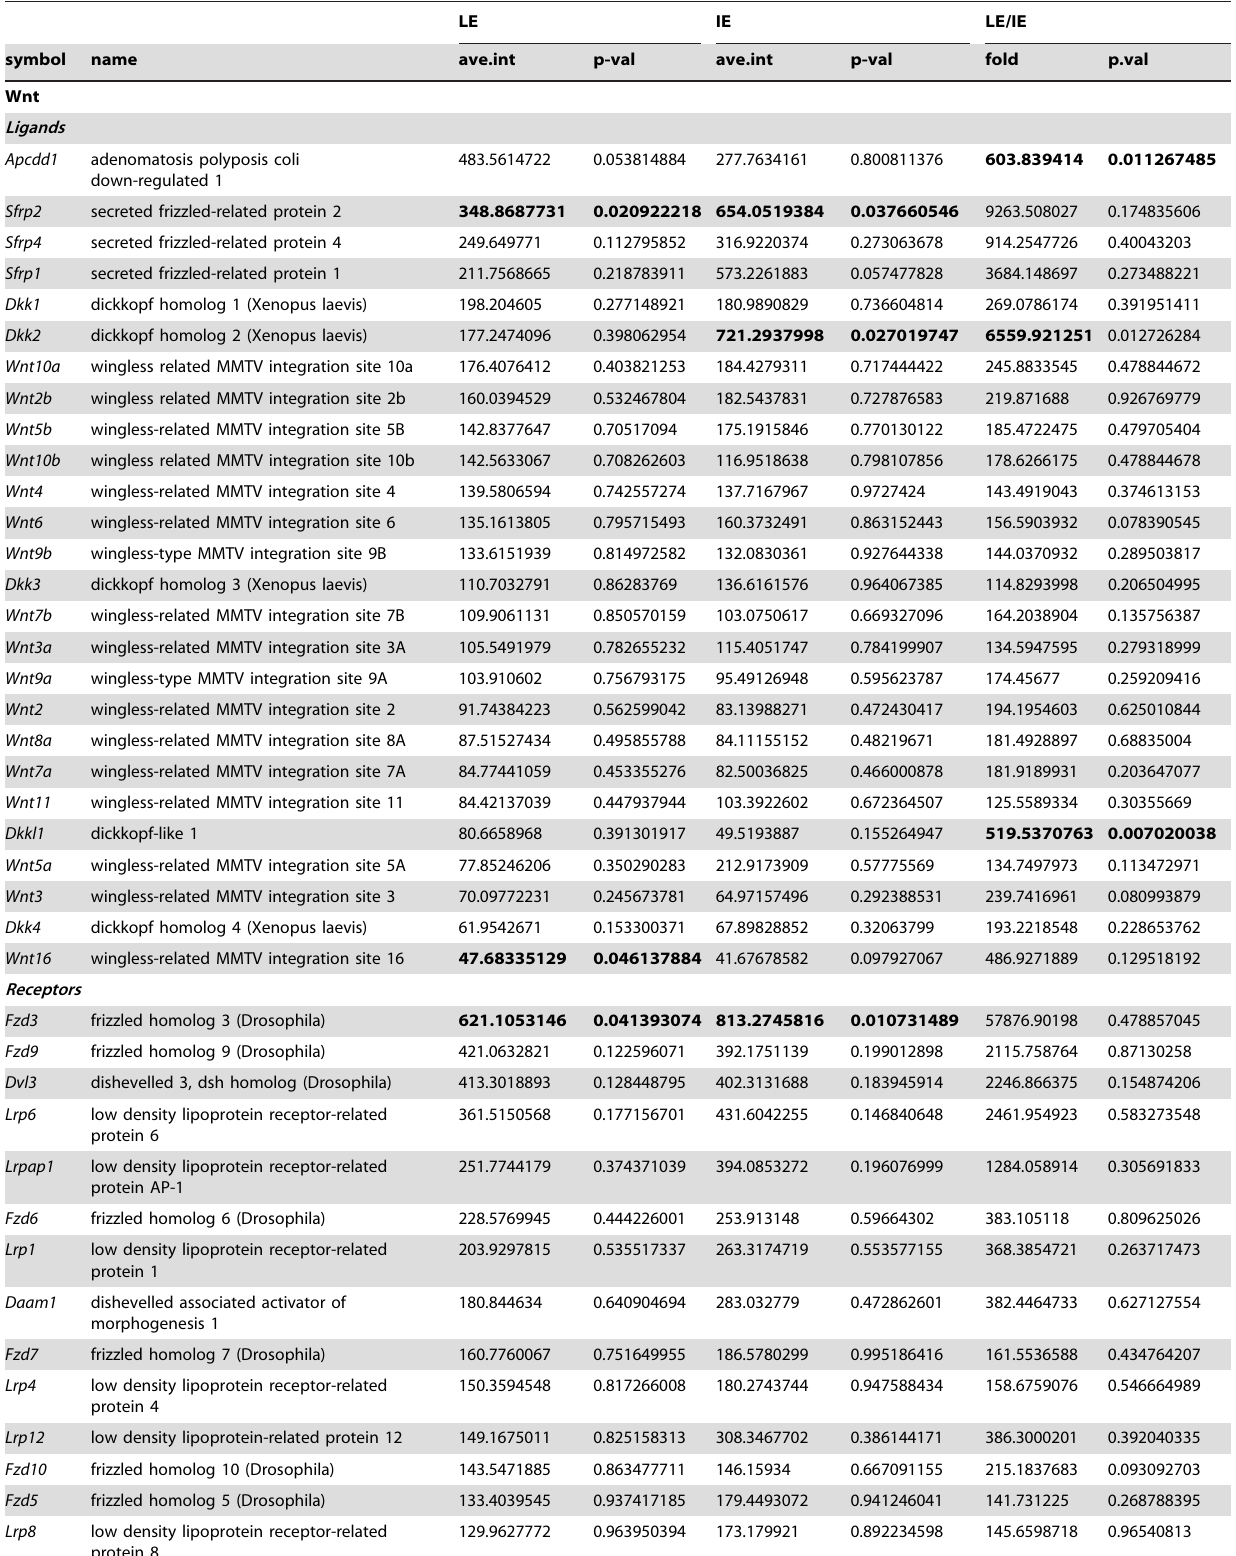
Table 7. Expression of genes in the Wnt